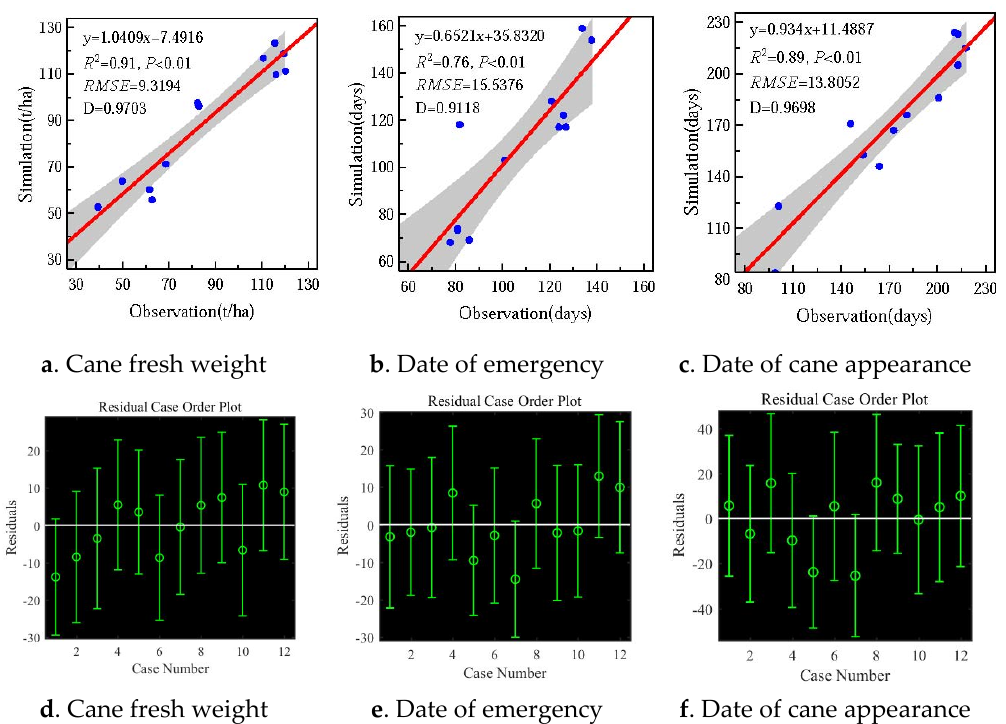
Figure 7. The linear regression diagrams (( a ) cane fresh weight; ( b ) date of emergency; ( c ) date of cane appearance) and the residual analysis diagrams (( d ) cane fresh weight; ( e ) date of emergency; ( f ) date of cane appearance) of the observed and simulated values.